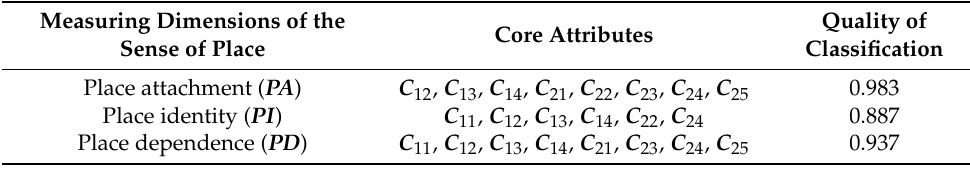
Table 3. Quality of classification and Extract core attributes.